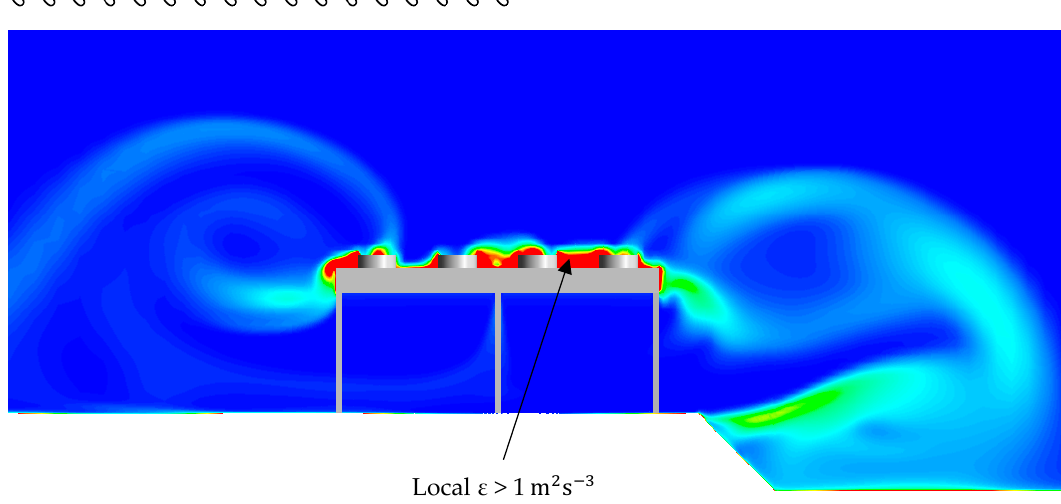
Figure 17. Turbulent kinetic energy dissipation contour at the cross-section of row 17, real field and south wind condition.